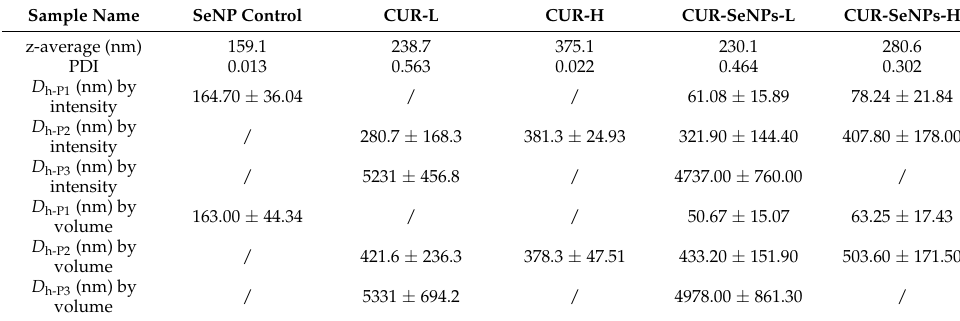
Table 1. Hydrodynamic-diameter distributions of CUR-SeNP samples.